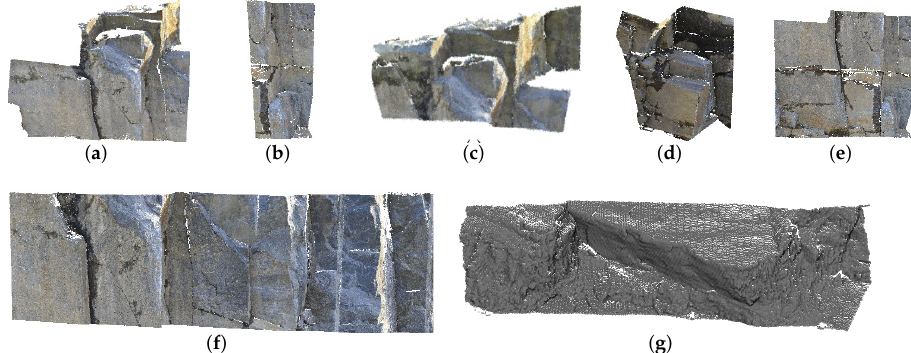
Figure 10. Seven datasets. ( a ) Rock 1. ( b ) Rock 2. ( c ) Rock 3. ( d ) Rock 4. ( e ) Rock 5. ( f ) Rock 6. ( g ) Rock